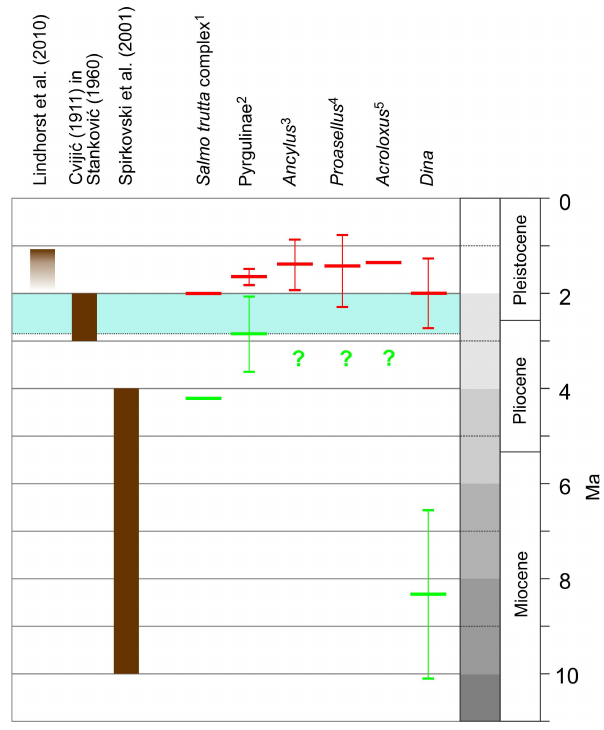
Fig. 5. Comparisons of geological and evolutionary estimates for the age of Lake Ohrid. Brown bars indicate geological estimates (note that the estimate of Lindhorst et al., 2010 represents a mini- mum age). The narrow red bars indicate the onset of diversification in groups of endemic Lake Ohrid taxa together with their standard deviations (not CI). The narrow green bars indicate the average tim- ing and standard deviations of the split with their respective sister groups outside the lake. These estimates set the minimum and a potential maximum time frame for the origin of Lake Ohrid faunas (turquoise band) based on evolutionary data. See text for details. 1 Suˇsnik et al., 2006. 2 Wilke et al., 2007, 2009. Note that the authors did not include all species of the Pyrgulinae species flock in their analysis. Therefore, the onset of diversification in this group is very likely underesti- mated. 3 Albrecht et al., 2006. Note that the authors regarded an endemic taxon from the feeder springs of Lake Ohrid as a non-Ohrid taxon. For reasons of consistency, this taxon is here considered to be part of the Ohrid group. 4 Wysocka et al., 2008. Note that the authors calculated the age for the older of two Proasellus groups at 2.83Ma. For their tree estima- K2P model for subsequent molecular dating. Here we have